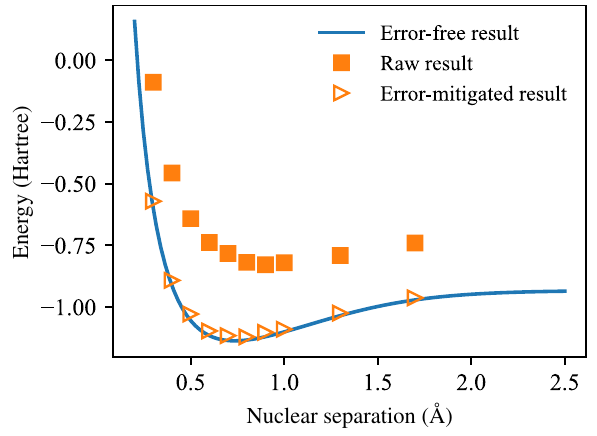
FIG. 11. Ground-state energy surface of H 2 in the minimal basis computed using the variational quantum eigensolver. The blue solid line is computed using package Qiskit . Square and triangular scatters represent results without and with the learning- based quantum error mitigation computed on ibmq_santiago